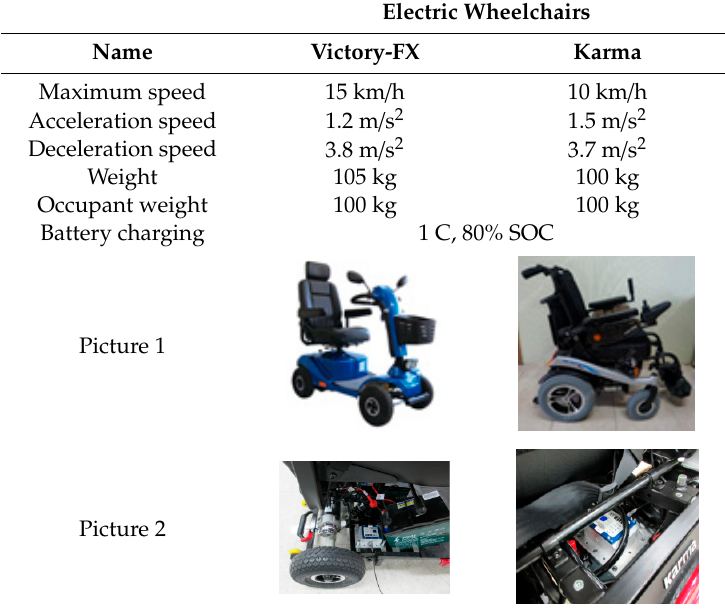
Table 1. Test Model.